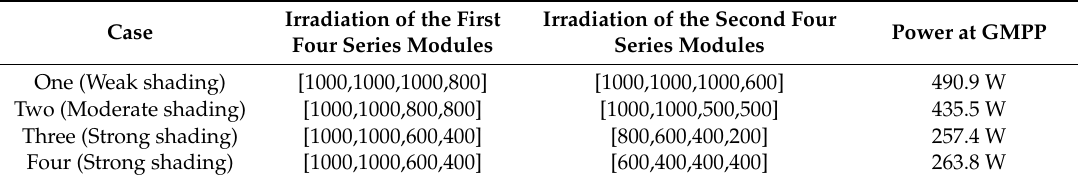
Table 2. Incident irradiation for the PV system array with the corresponding power at the global maximum power point (GMPP).